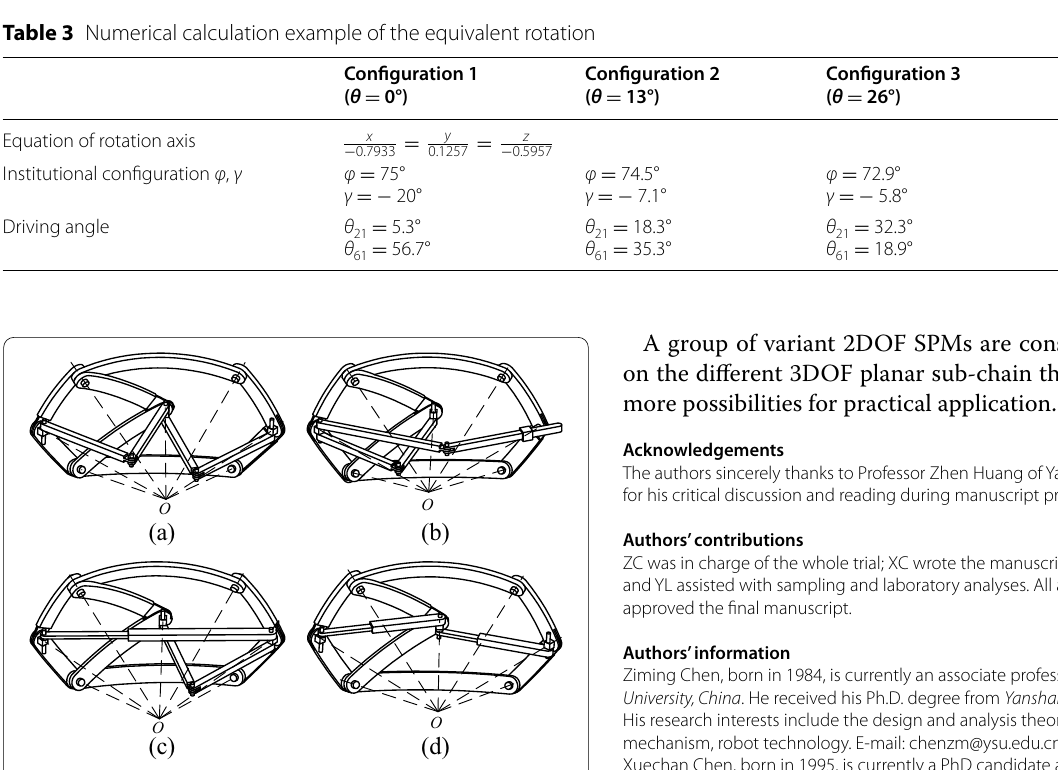
Figure 9 Several 2DOF SPMs based on 3DOF planar